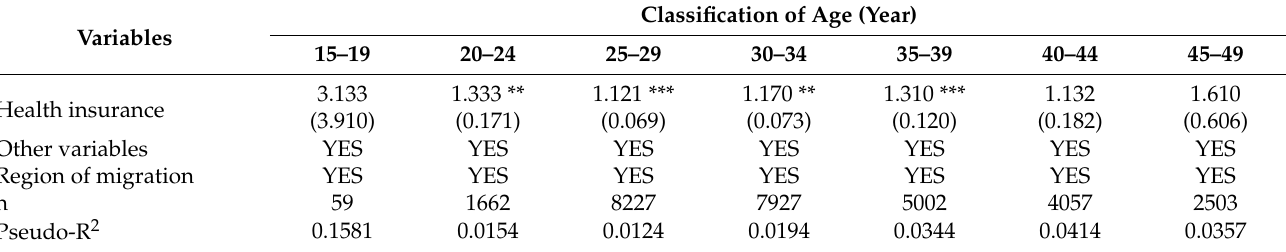
Table 5. Results of age